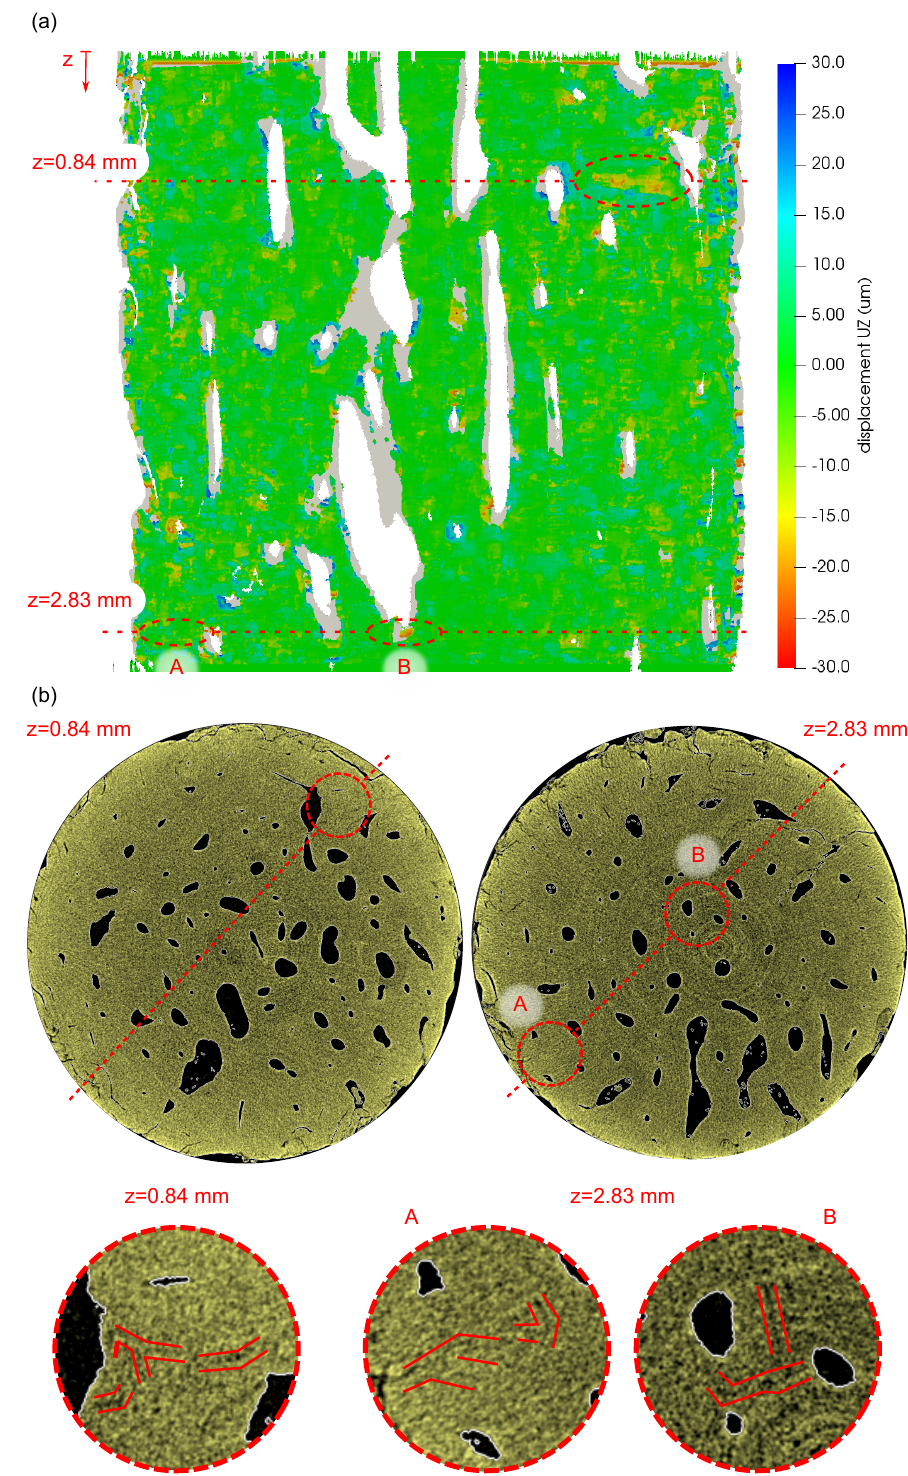
Figure 13. The results of the DVC procedure and comparison with the transversal slices in the blended volume: ( a ) u z —vertical displacement field calculated in “plane 1”, ( b ) slices and details of the bone microstructure at the coordinates z = 0.84mm and z = 2.83mm, where regions A and B show detailed views on the identified